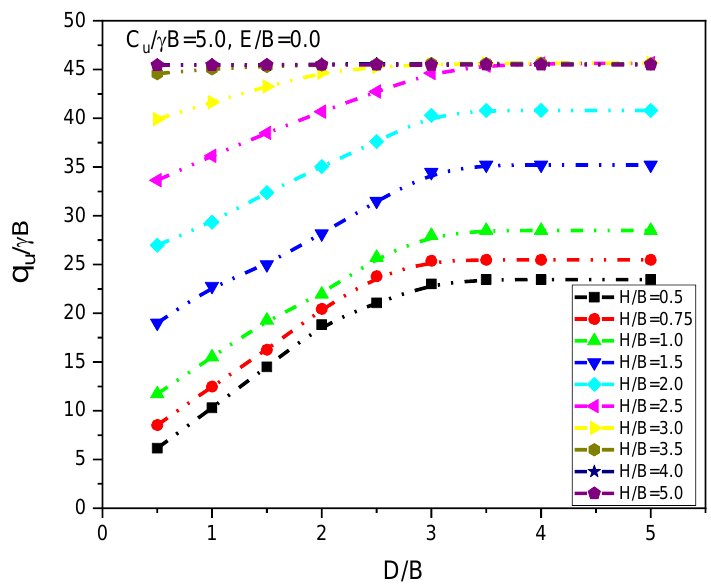
Figure 6. Effect of D/B on the ultimate bearing capacity ratio qu/γB.